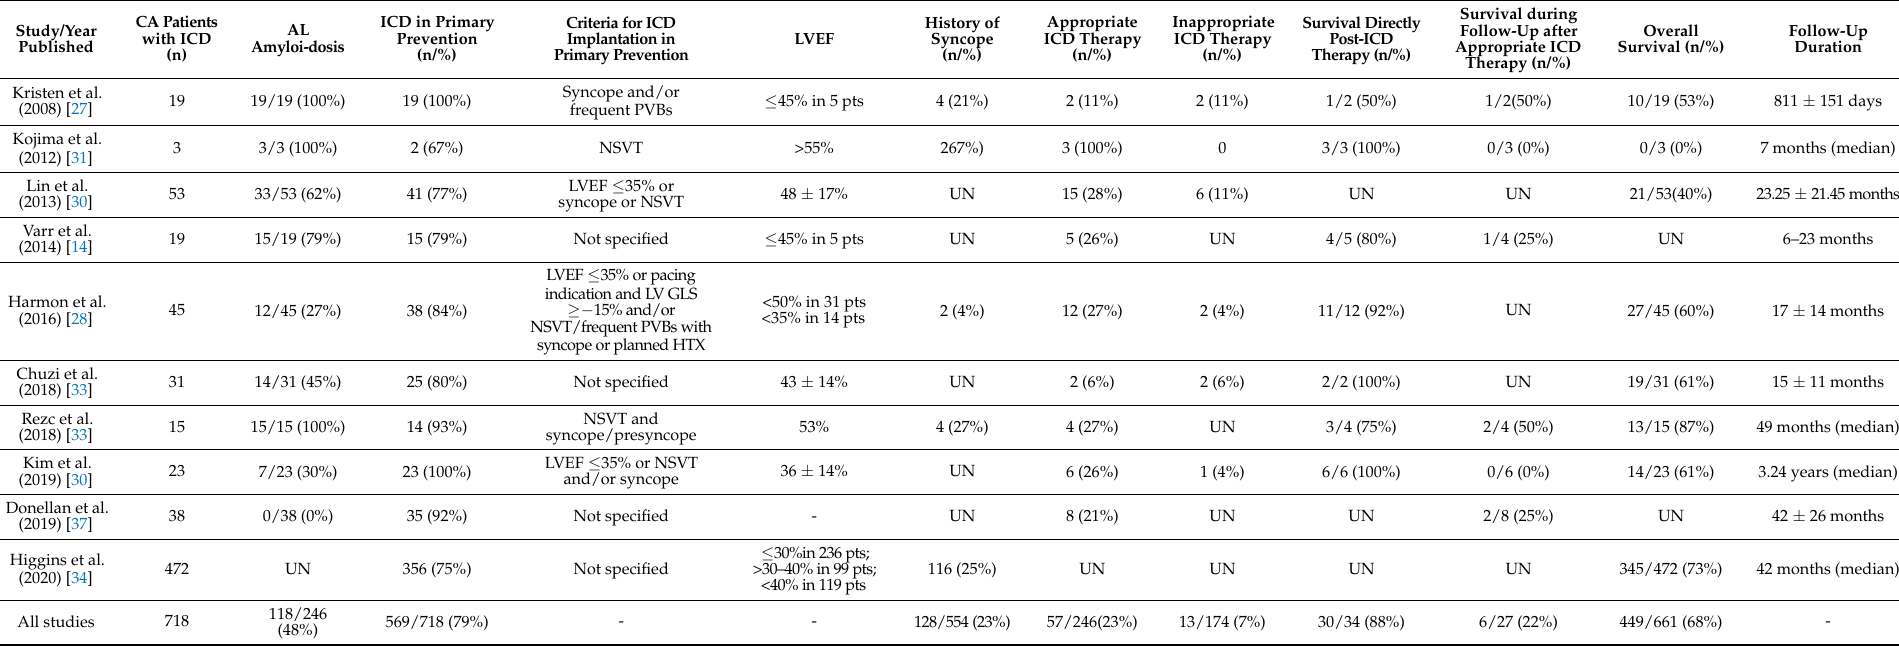
Table 1. Studies reporting on treatment with implantable cardioverter-defibrillator and survival in patients with cardiac